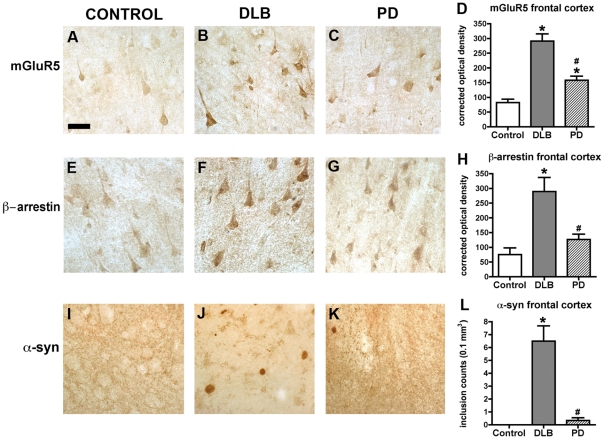
Immunohistochemical analysis of mGluR5, beta-arrestin and alpha-syn in the frontal cortex of Control, DLB and PD cases.(A, B, C) Representative bright field microscopy images of mGluR5 immunoreactivity in the frontal cortex of control, DLB and PD cases respectively. (D) Analysis of mGluR5 immunoreactivity in the frontal cortex of control, DLB and PD cases. (E, F, G) Representative bright field microscopy images of beta-arrestin immunoreactivity in the frontal cortex of control, DLB and PD cases respectively. (H) Analysis of beta-arrestin immunoreactivity in the frontal cortex of control, DLB and PD cases. (I, J, K) Representative bright field microscopy images of alpha-syn immunoreactivity in the frontal cortex of control, DLB and PD cases respectively. (L) Analysis of alpha-syn immunoreactivity in the frontal cortex control, DLB and PD cases. Scale bar  = 30 µM. * Indicates a significant difference between DLB or PD cases compared to control cases (p<0.05, one-way ANOVA and post hoc Fisher). # Indicates a significant difference between DLB and PD cases (p<0.05, one-way ANOVA and post hoc Fisher) (n = 8 cases per group).